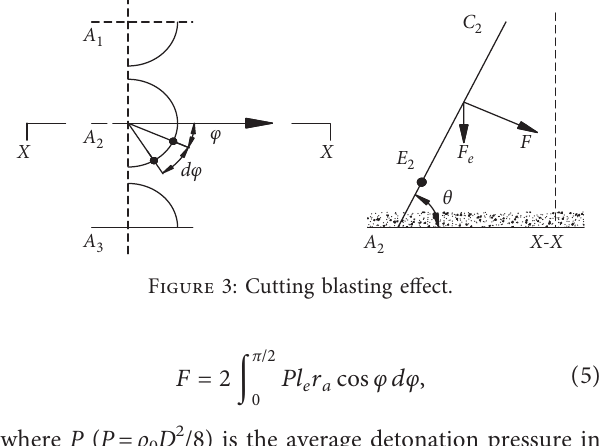
Figure 3: Cutting blasting